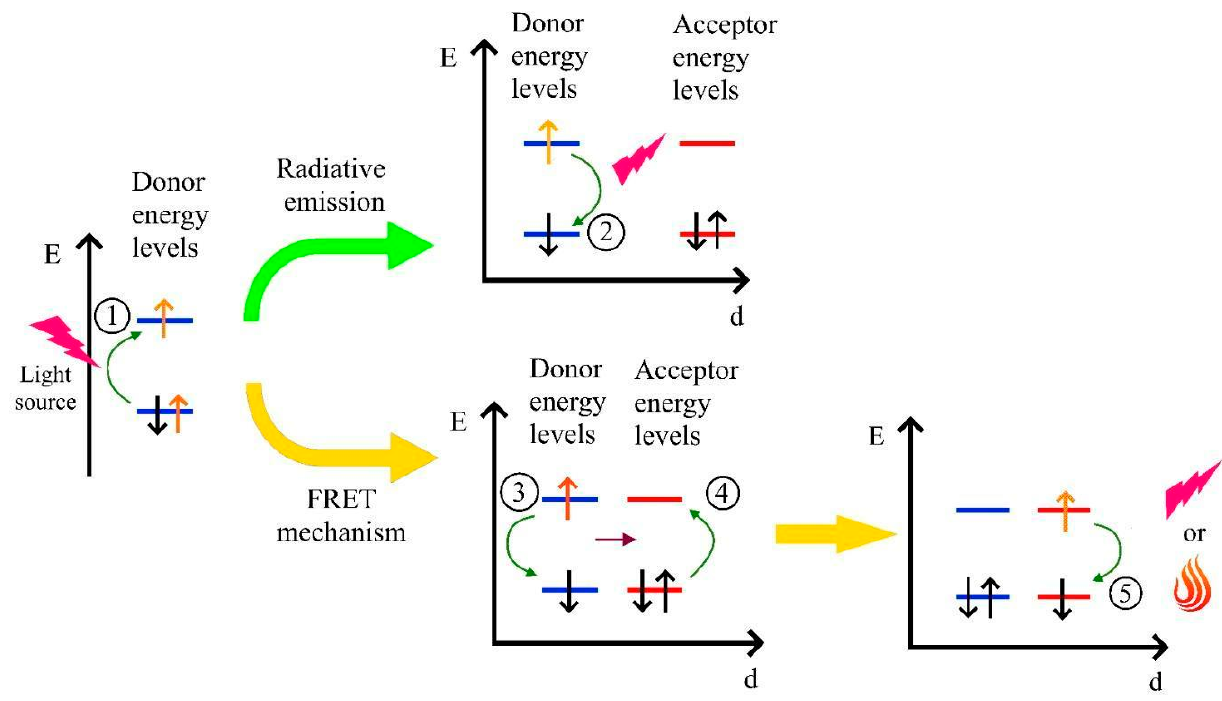
Scheme 3. Schematic representation of processes involved between two fluorophores, a donor and an acceptor in the fluorescence resonance energy transfer (FRET) mechanism.